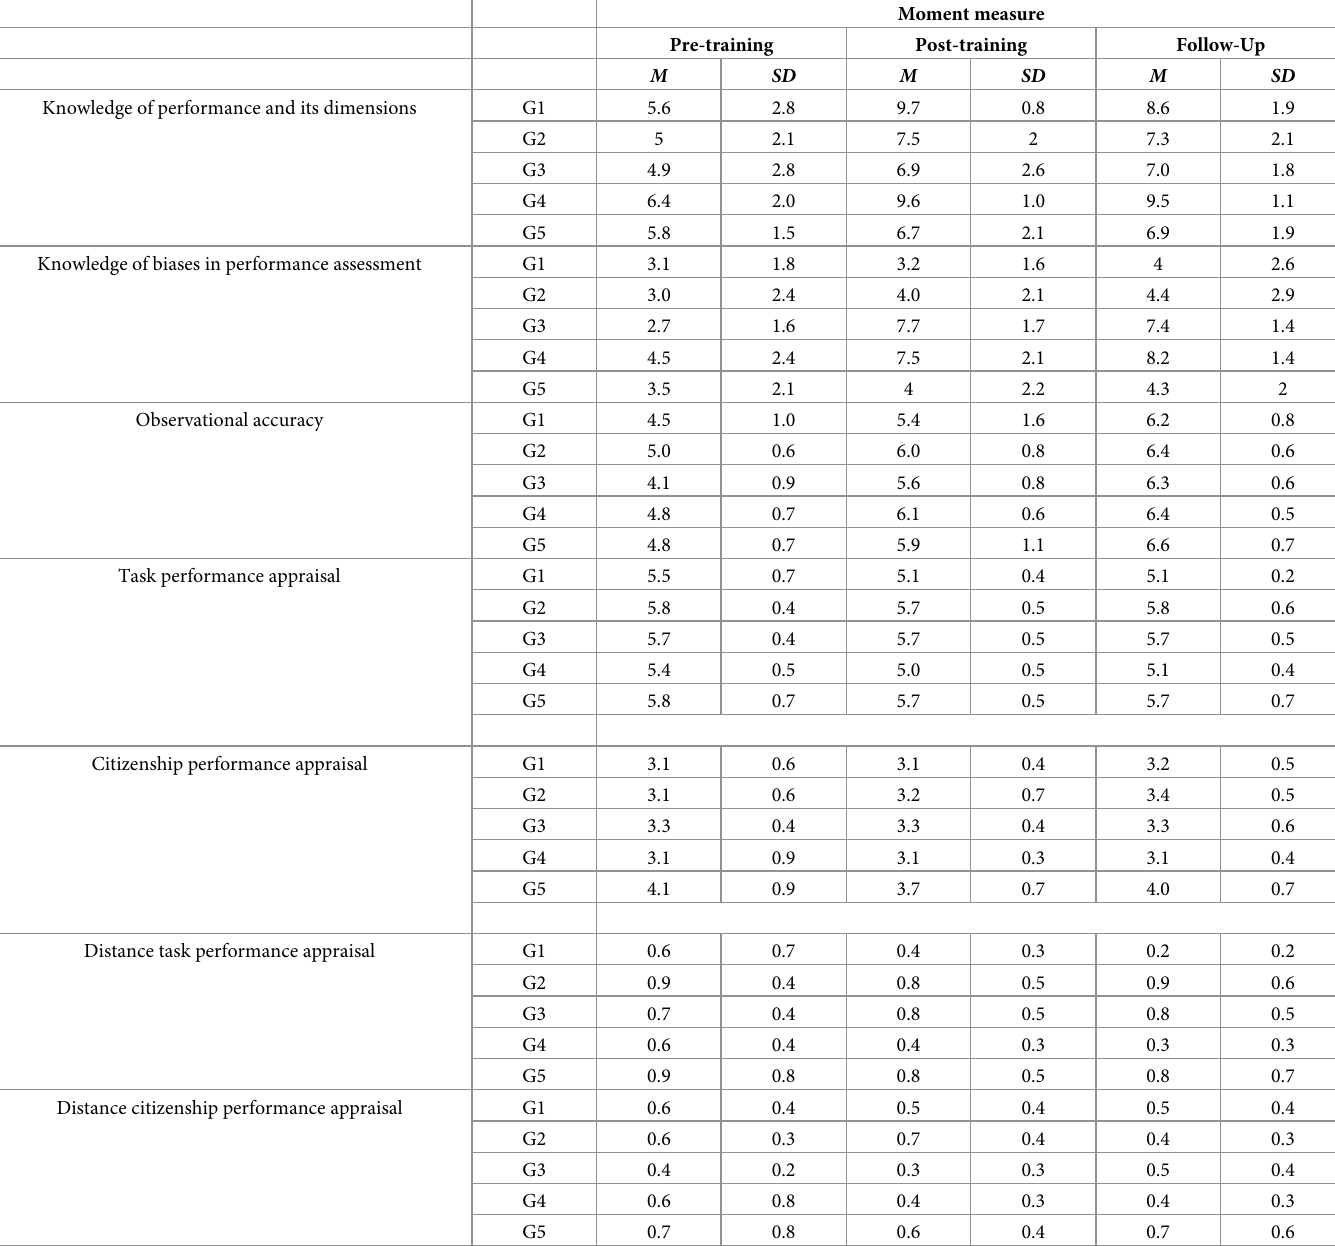
Table 1. Descriptive statistics of the dependent variables in each training group and moment measure